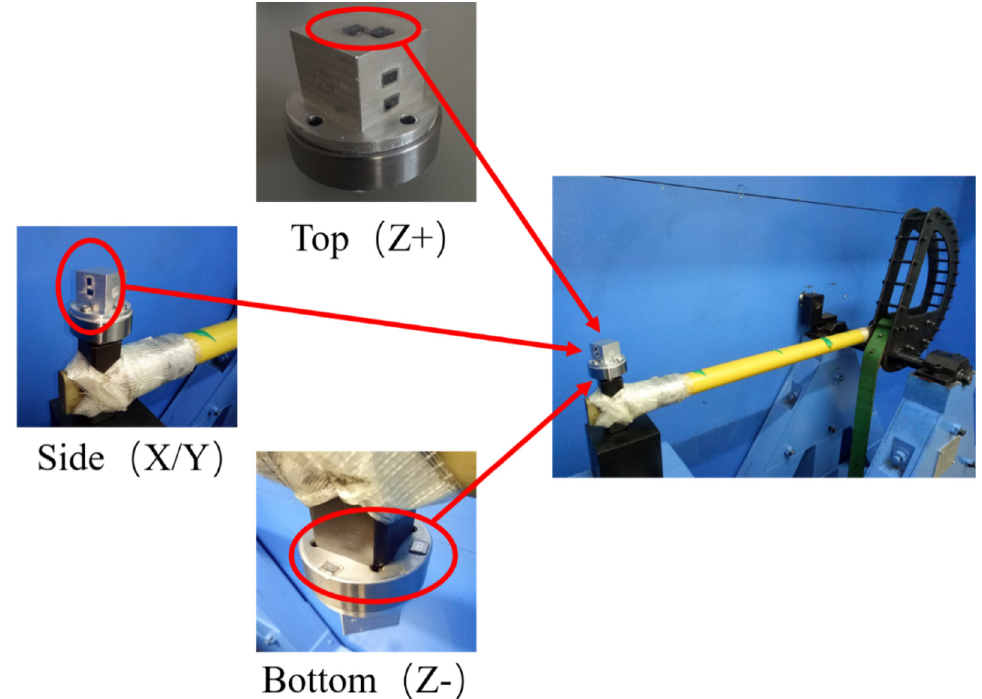
Figure 14. The fitted curves based on the measured acceleration pulses with different shock levels.